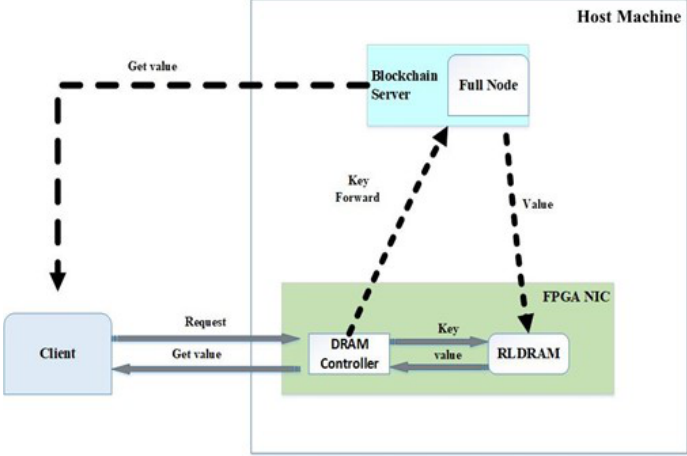
Figure 1. Hardware cache system for a cache hit and cache miss. Table 2. Summary of recent state-of-the-art Blockchain implementations to accelerate Blockchain. Key Idea Results Obtained Throughput improvement of